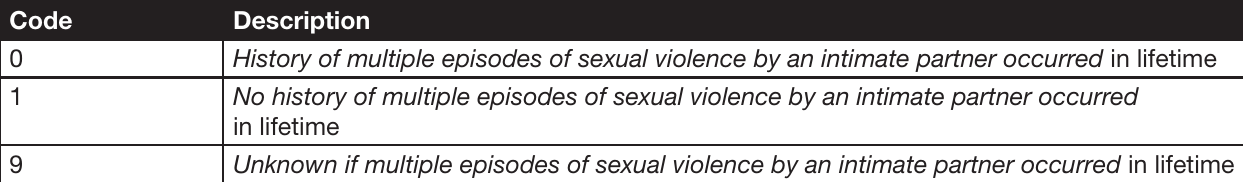
INTIMATE PARTNER VIOLENCE: UNIFORM DEFINITIONS AND RECOMMENDED DATA